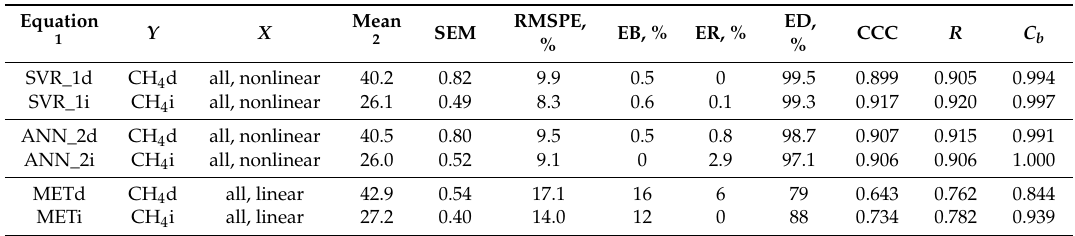
Table 6. Machine learning and meta-analysis (including all the X variables) model evaluation via root mean square prediction error (RMSPE) and concordance correlation coe ffi cient (CCC) analysis on the internal evaluation ( n = 107)